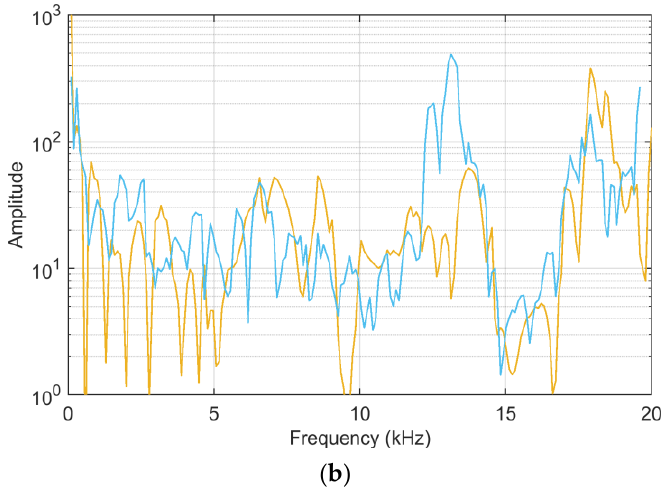
Figure 15. Normalized sensitivity coefficients for Z (45.0 km) and Z (45.5 km) with input data provided in ( a ) linear and ( b ) logarithmic scale: S ADMi is shown in light brown and S FDMi in light blue.